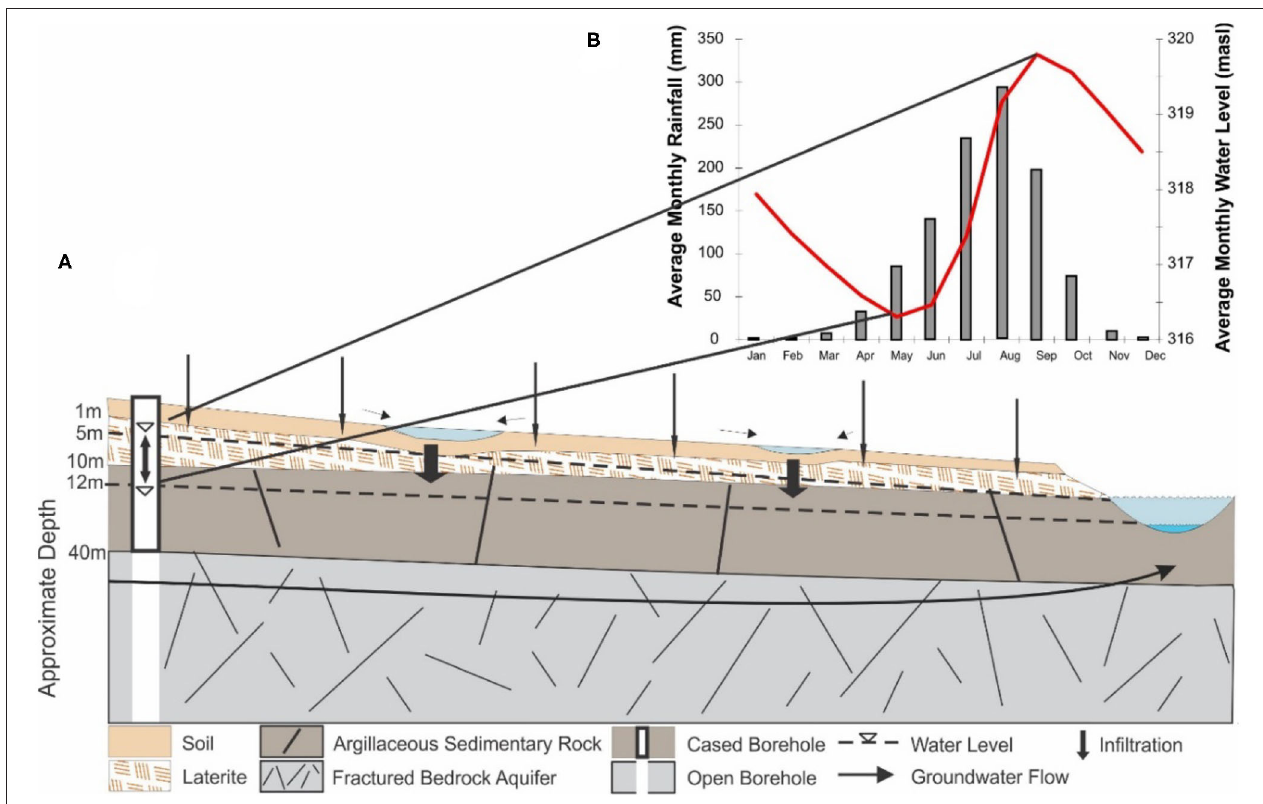
FIGURE 3 | (A) Conceptual geological model and recharge environment in southern Mali. (B) Representative groundwater level hydrograph and regional average